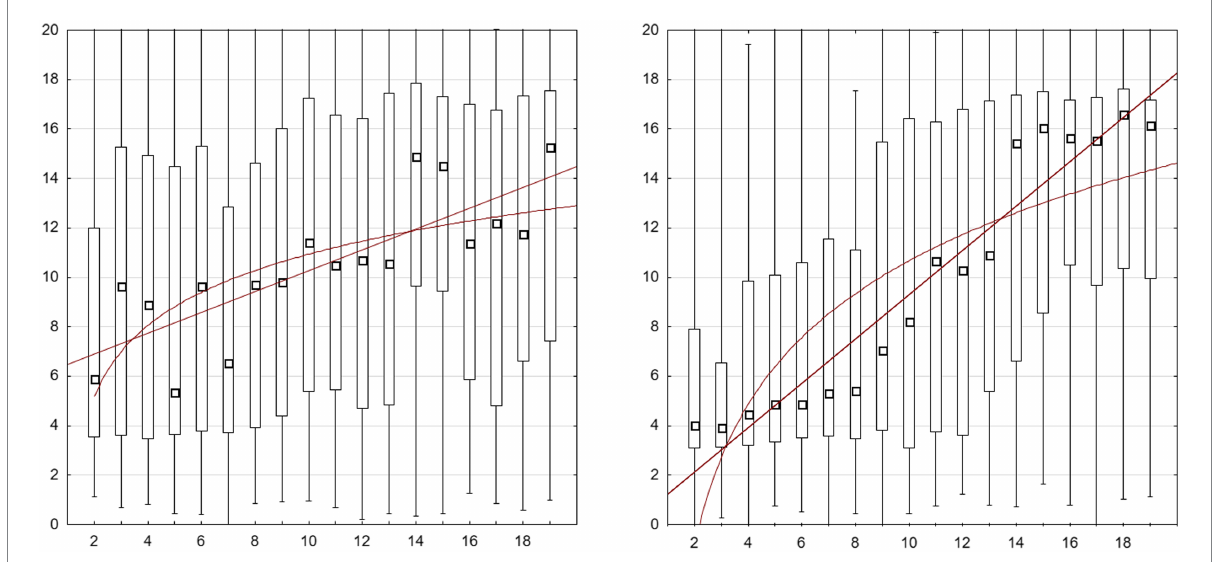
FIGURE 2 Experiment 1: Distribution of estimated positions on a line based on single data from two runs in both directions of the line. The black square represents the median, the box contains 50% of the middle choices, the bars represents the full range of choices. Left graph: subset-knowers, right graph: CP-knowers. Best fit linear and logarithmic functions plotted on both graphs. For distribution and model fit of group medians in division onto CP-knowledge level and line orientation see Supplemental